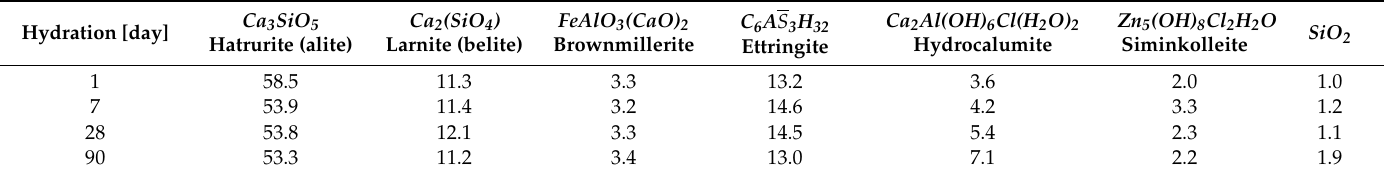
Table 5. Mineral composition of sample with ZnCl 2 .